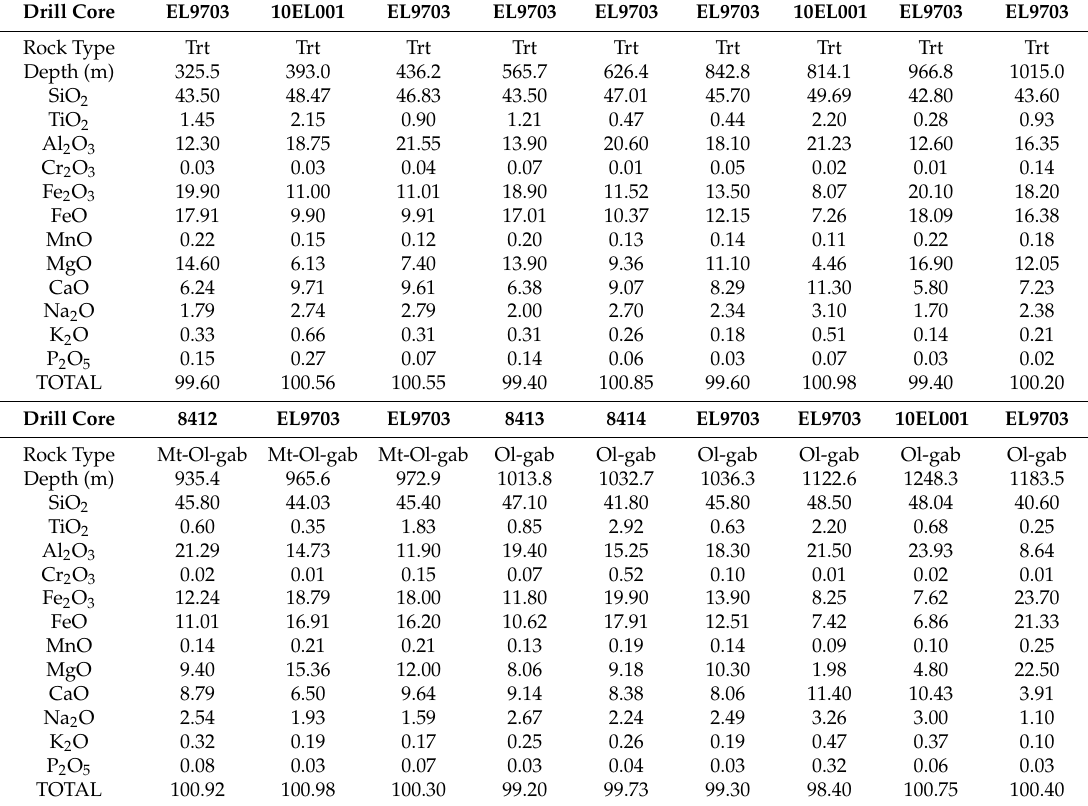
Table 1. Major element compositions of principal rock types.